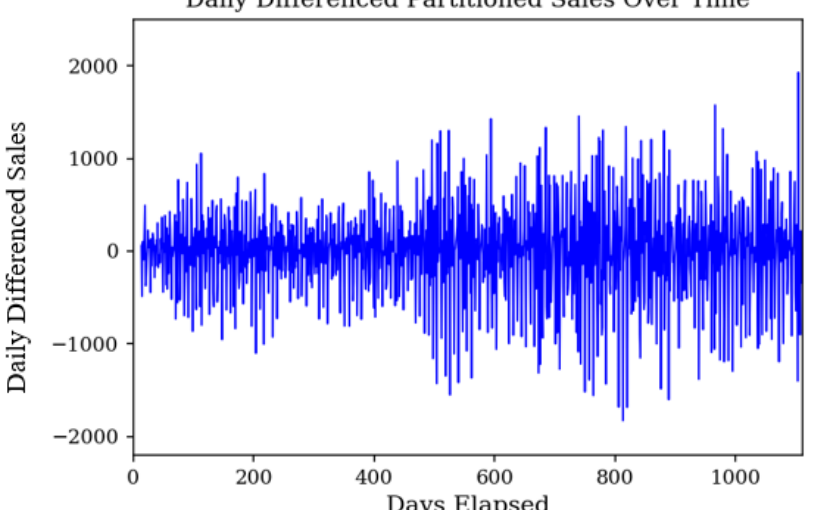
Figure 4. Daily Differenced Sales. We plot the daily differenced sales generated using Equation (1) for each instance in the dataset.